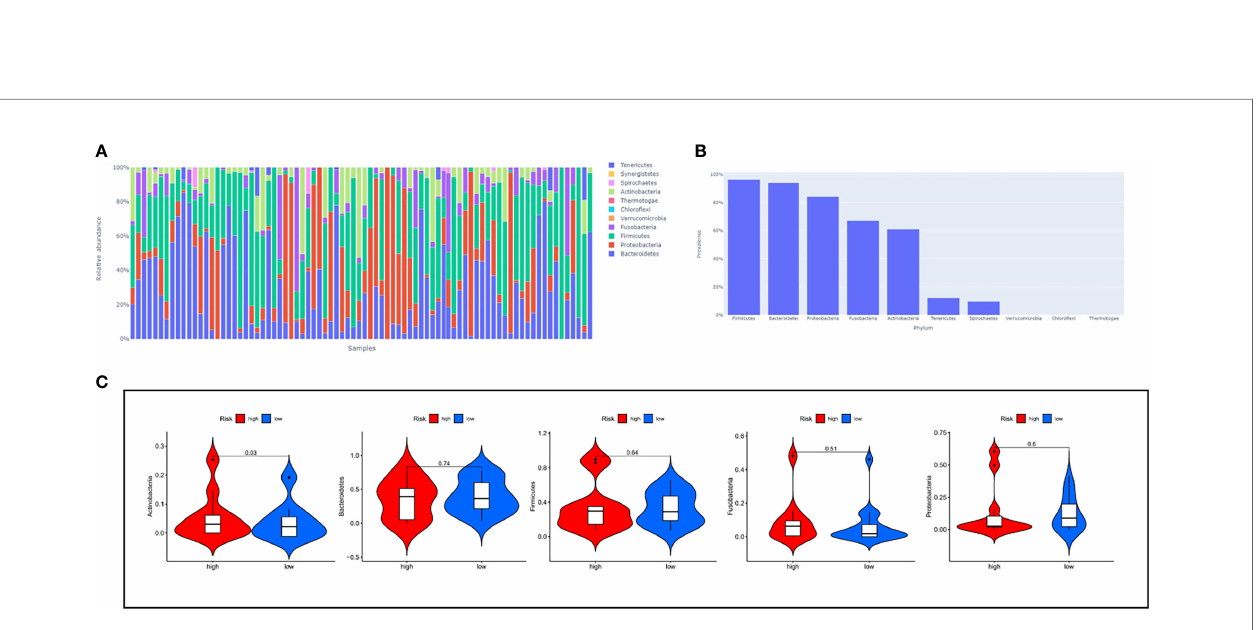
FIGURE 9 | The relationship between risk-score model and microbiota landscapes. (A) Distribution of different sample fl ora. (B) The top fi ve most abundant microbial phyla in ESCC. (C) The expression levels of fi ve microbial phyla between high- and low-risk